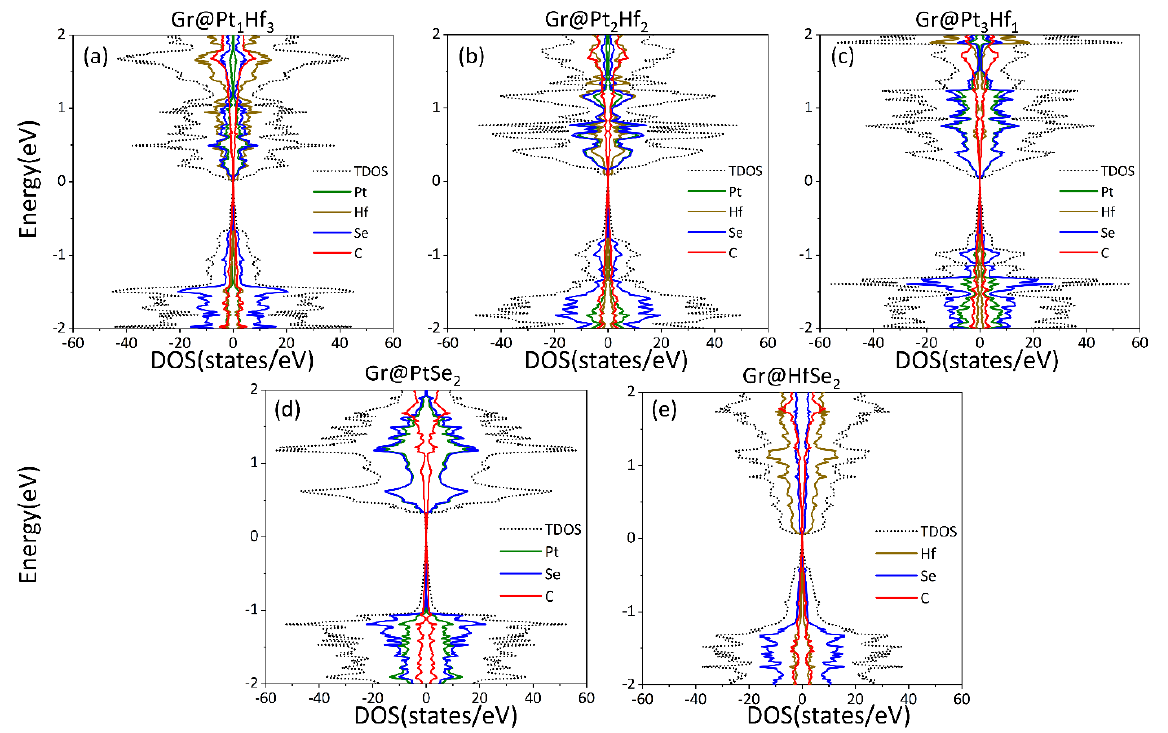
Figure 8. Calculated DOS and PDOS for ( a ) Gr@Pt 1 Hf 3 , ( b ) Gr@Pt 2 Hf 2 , ( c ) Gr@Pt 3 Hf 1 , ( d ) Gr@PtSe 2 , and ( e ) Gr@HfSe 2 . An energy level of zero is assigned to the Fermi level.